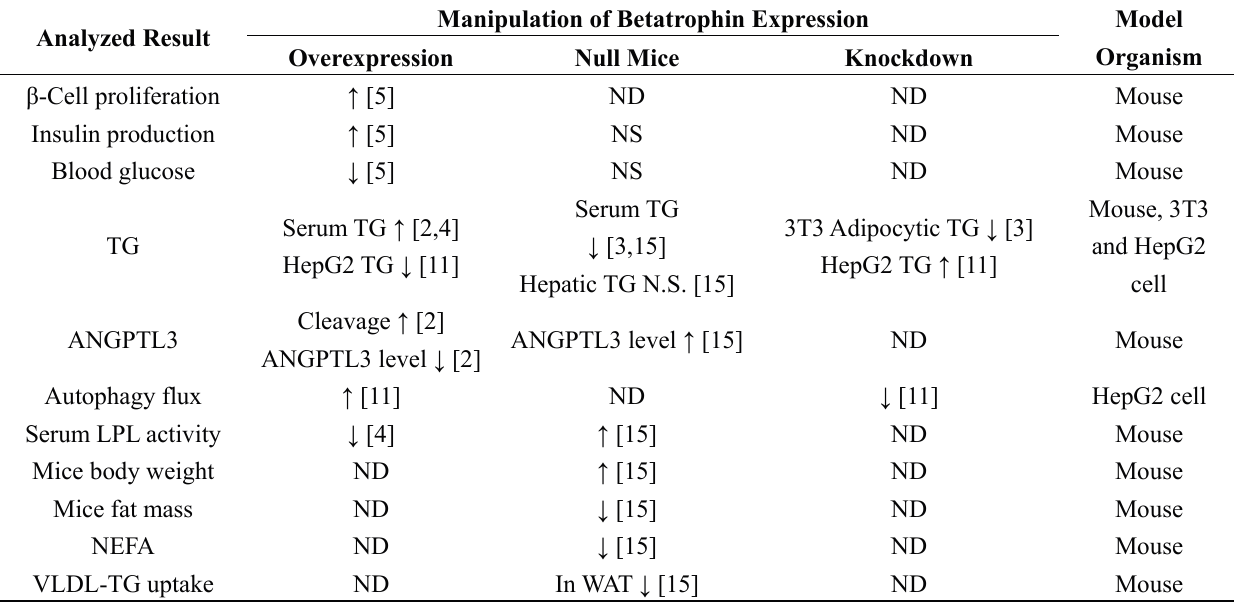
Table 3. Functional characterization of